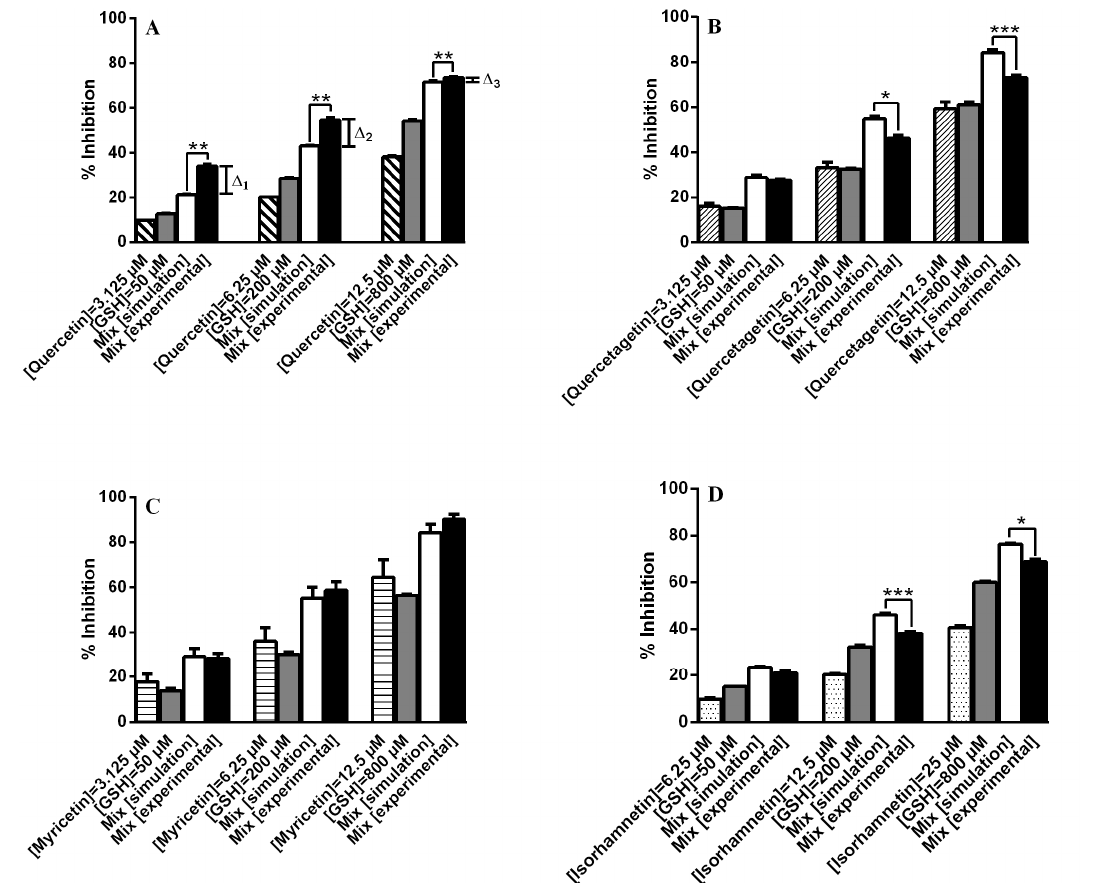
Figure 3. Antioxidant activity of binary mixtures of six flavonols (( A ) Quercetin; ( B ) Quercetagetin; ( C ) Myricetin; ( D ) Isorhamnetin; ( E ) Galangin; ( F ) Fisetin) with GSH (mean ± SEM of three determinations). * p < 0.05, ** p < 0.01, *** p <